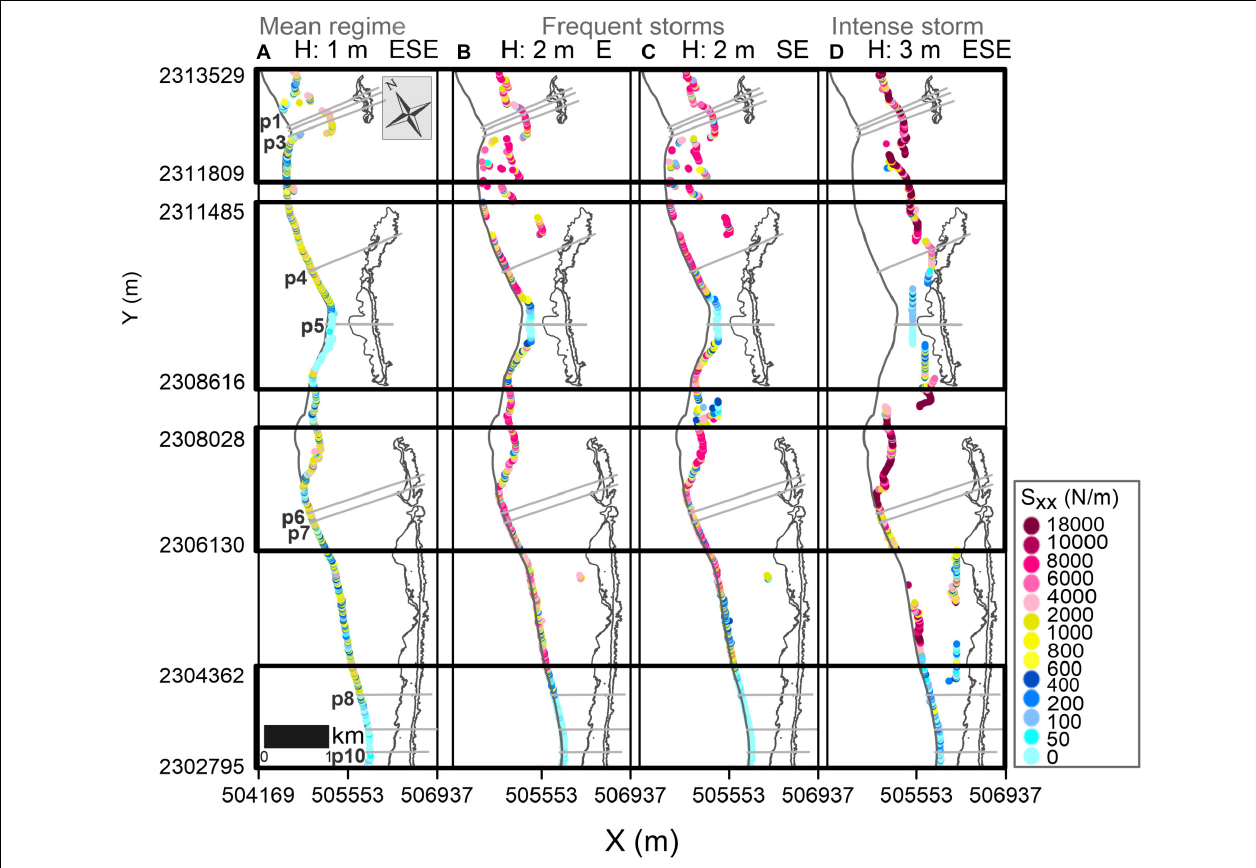
FIGURE 11 | Cross-shore radiation stresses at the breaking point. High values indicate more cross-shore sediment transport potential.